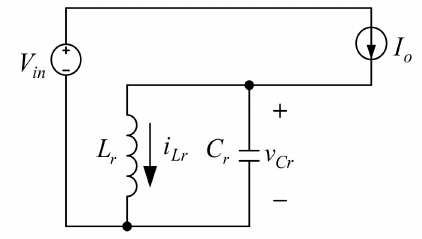
Figure 7. Equivalent circuit in state